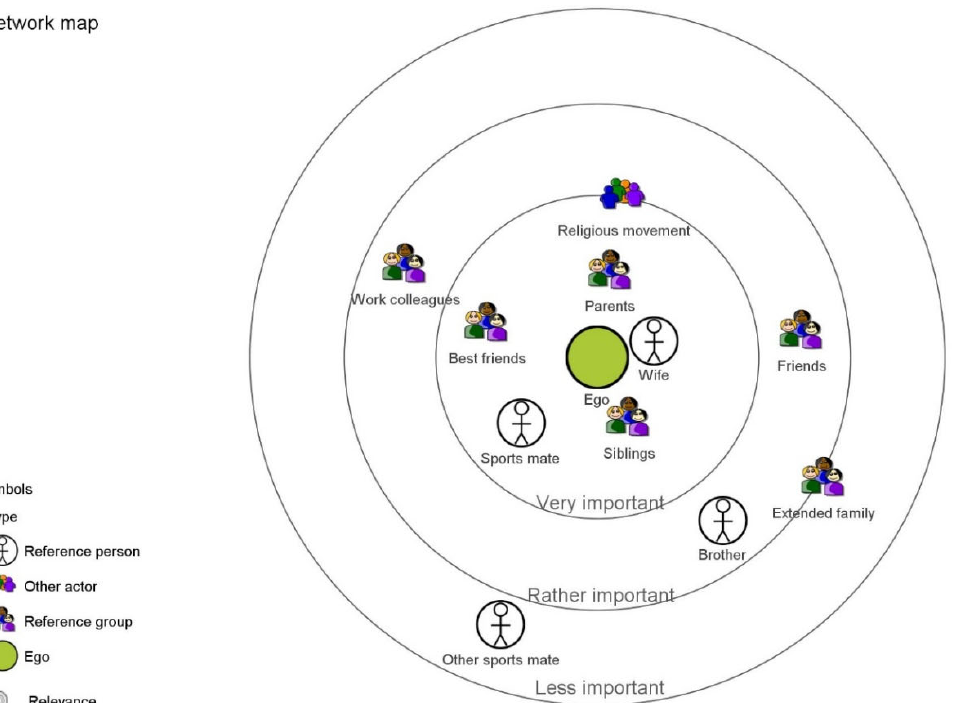
Figure 2. Ufuk’s egocentric network chart